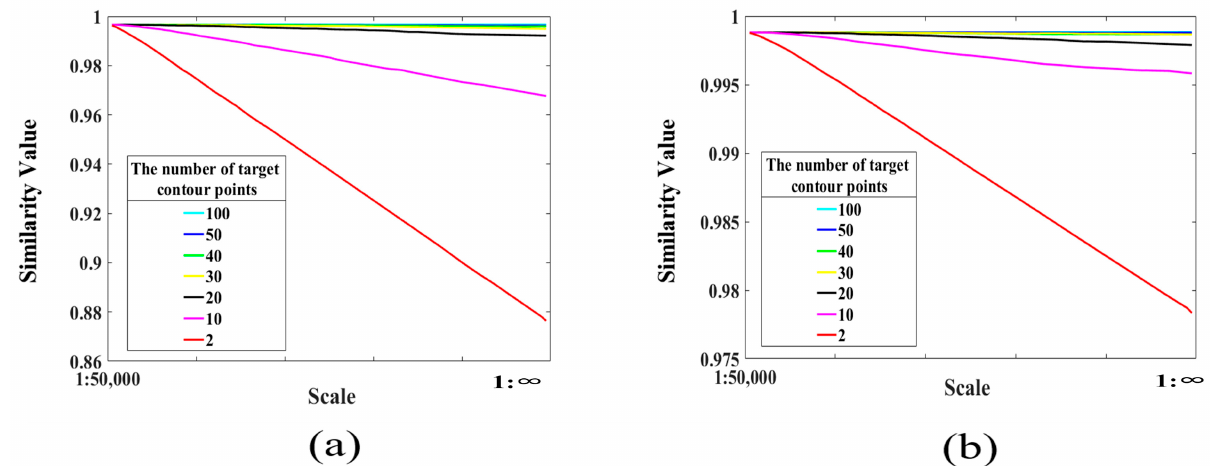
Figure 16. Relationship between the scale and similarity of the target contours at different points. ( a ) Relationship between the scale and similarity of contours in Figure 15a. ( b ) Relationship between the scale and similarity of contours in Figure 15b.